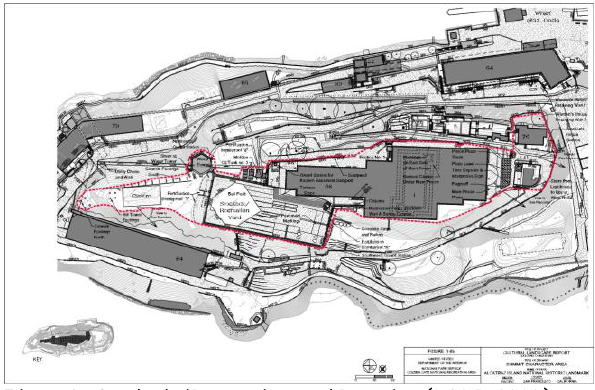
Figure 2. Stockade/ Recreation yard Drawing (ACLR